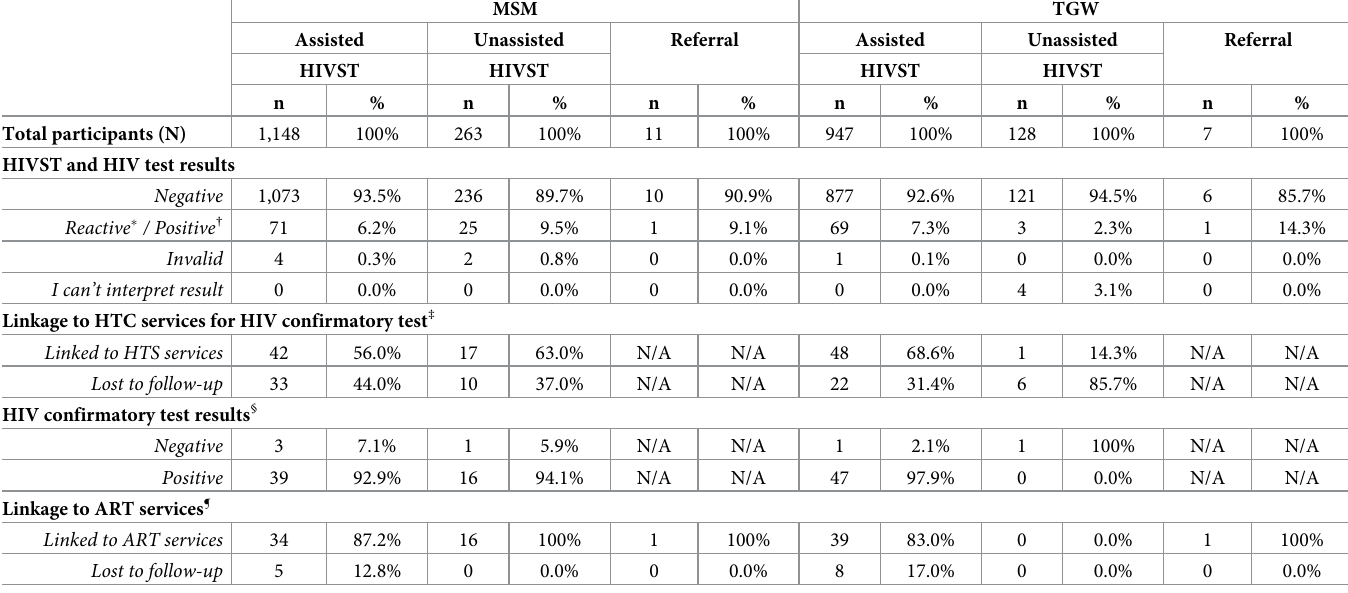
Table 6. Outcomes of HIV testing by testing